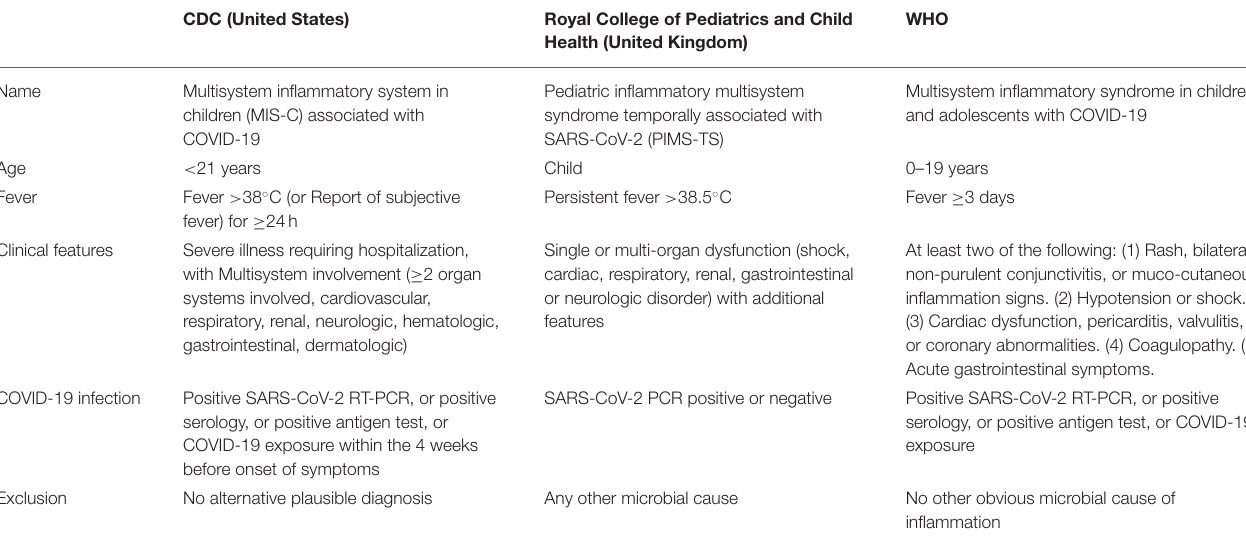
TABLE 1 | Case definitions of multisystem inflammatory syndrome in children (14–16).